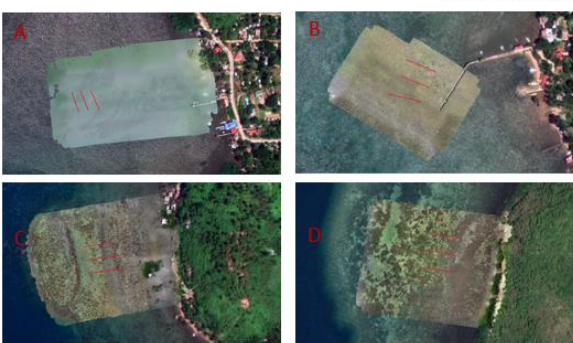
Figure 4. Processed UAV orthophotos and SAV transect plots